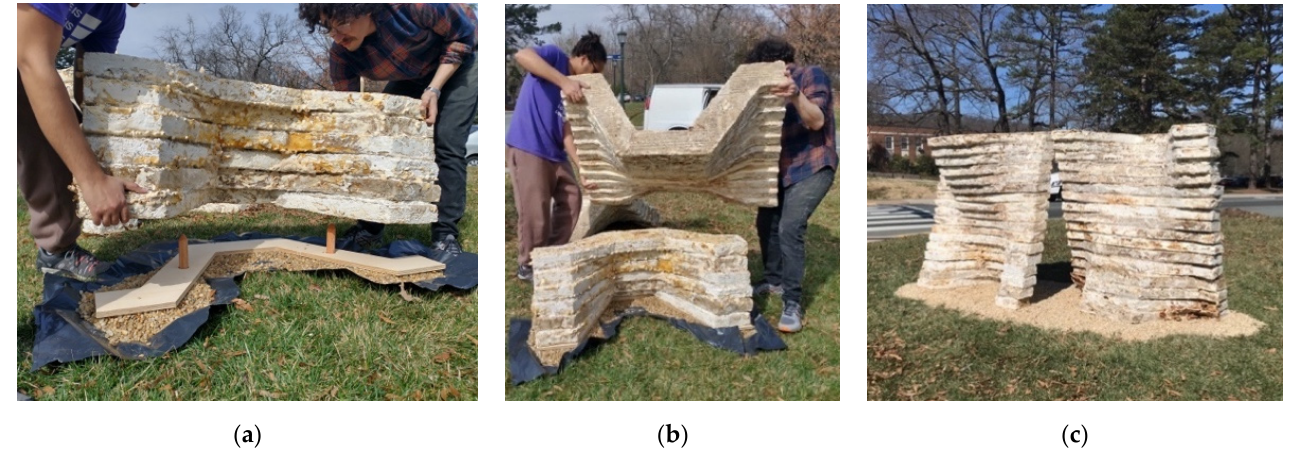
Figure 10. Installation of the prototype onsite: ( a ) friction fitting base chunk to the anchoring stakes in the ground; ( b ) friction fitting upper chunk of the myco-welded wall; ( c ) complete structure as it was exhibited at the biomaterials building exposition. Photos by the author and Leila Ehtesham.